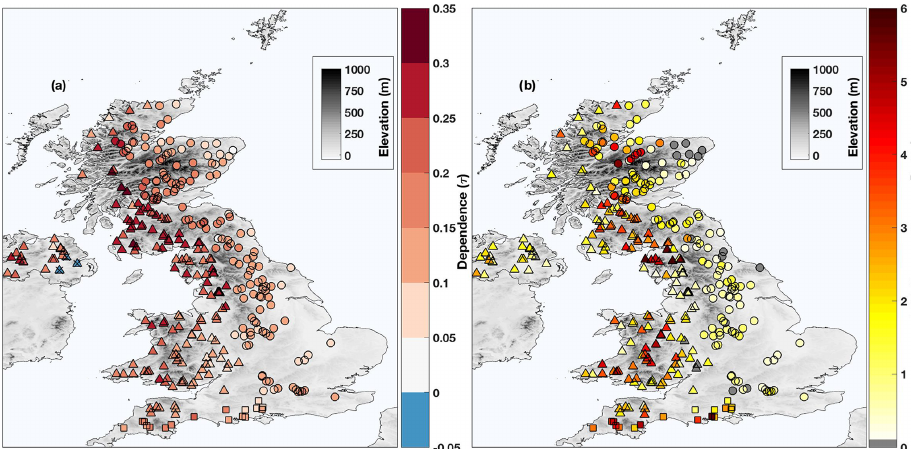
Figure 4. (a) Kendall’s rank correlation τ between daily maximum skew surge and daily maximum river discharge and (b) number of joint occurrences per decade between extreme skew surge and extreme river discharge at 0-day lag. Sites with a cross through them in (a) represent the dependence is not being statistically significant (95% confidence) at these sites. Note that the triangles, circles, and squares show the river stations that discharge onto the western, eastern, and southern coasts,